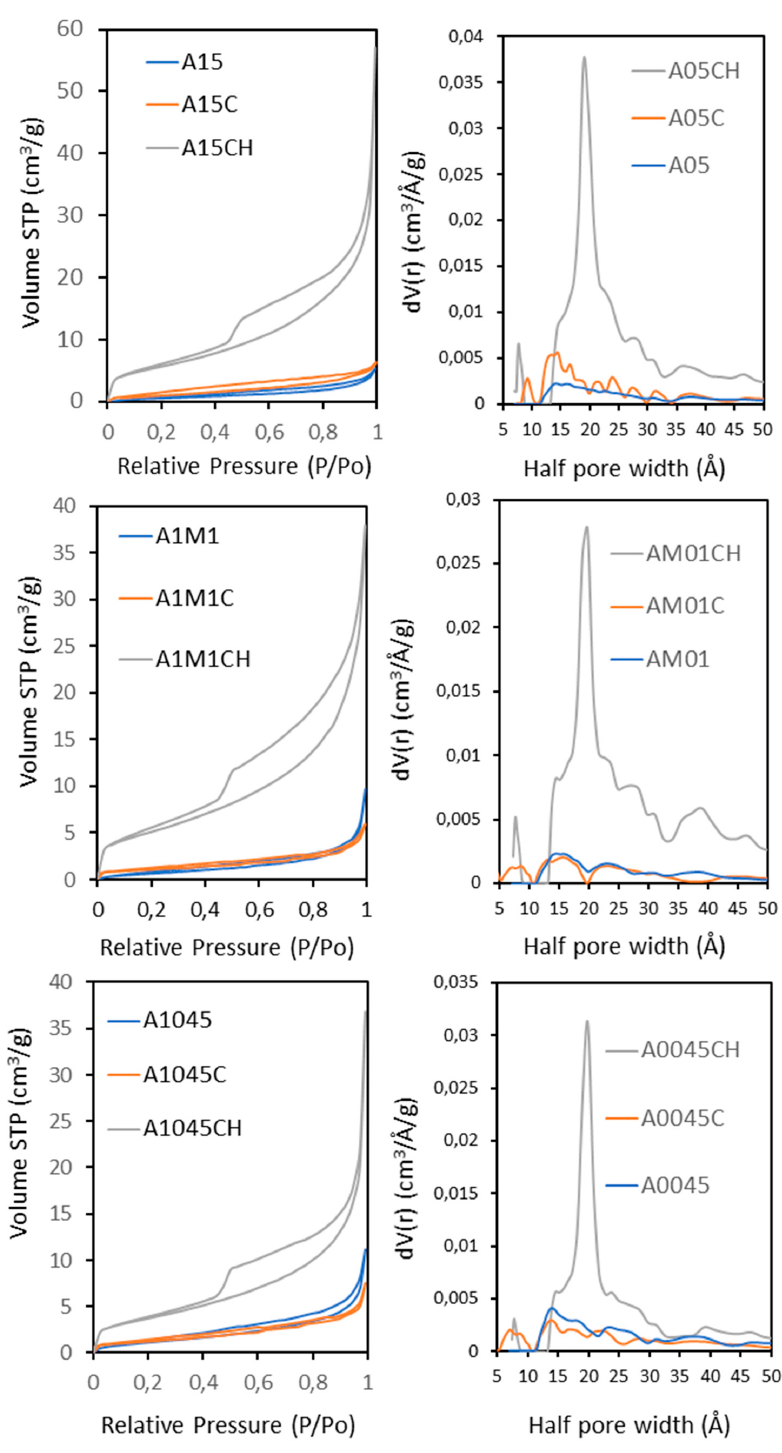
Figure 3. (Left) Nitrogen adsorption–desorption isotherms for calcites: A1045, A1M1, and A15; calcites calcined: A1045C, A1M1C, A15C and calcites calcined and rehydrated: A1045CH, A1M1CH, and A15CH. (Right) Pore size distributions for calcites: A1045, A1M1, and A15; calcites calcined: A1045C, A1M1C, A15C, and calcites calcined and rehydrated: A1045CH, A1M1CH, and A15CH.